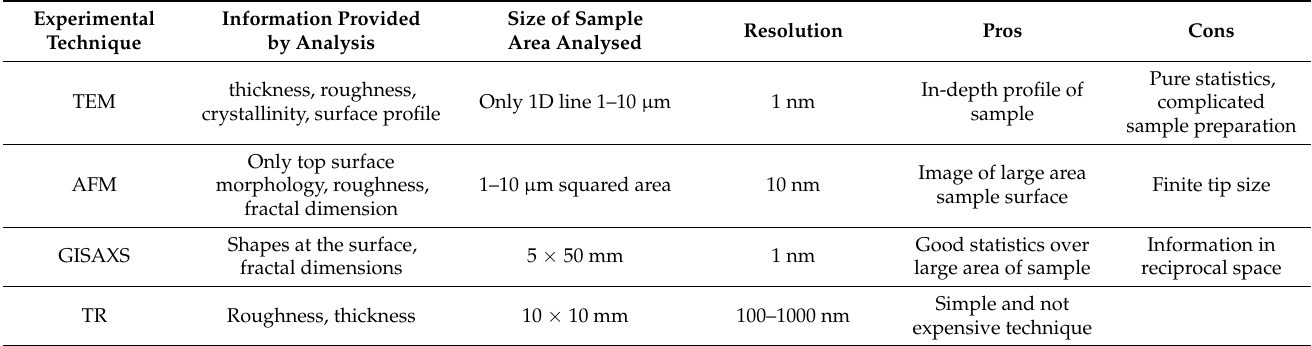
Table 4. Characteristics summary of all used experimental techniques for surface morphology analysis of SnO 2 thin films on glass